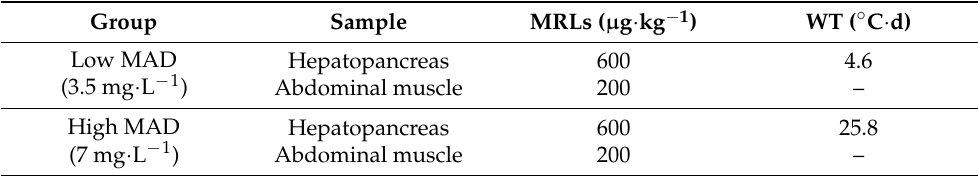
Table 3. Maximum residue limits (MRLs) and withdrawal times (WTs) of two levels of maduramicin (MAD) in crayfish.